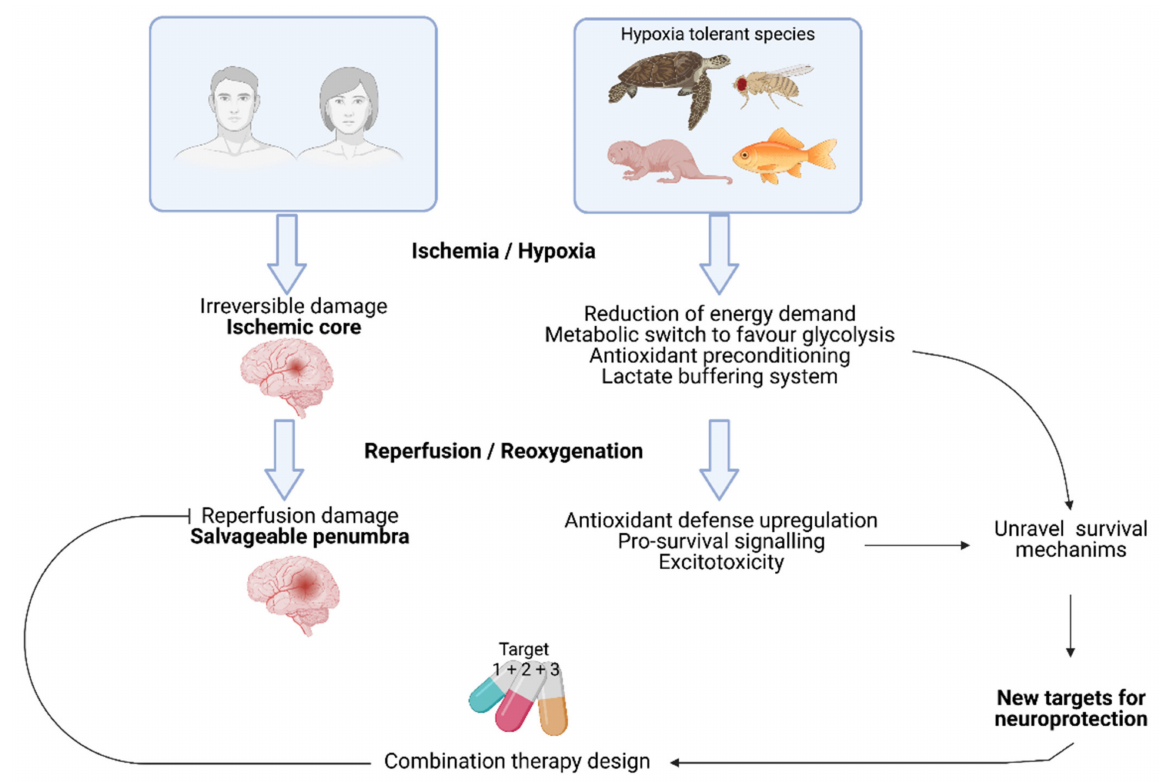
Figure 1. Human brain quickly undergoes irreversible cell death during ischemia. However, the surrounding penumbra is a salvageable tissue. Hypoxia tolerant brains have evolved different complementary mechanisms to deal with the lack of oxygen for prolonged periods of time that are not fully understood. A better knowledge of the survival mechanisms used by these animal species at the molecular level can provide new targets for neuroprotection that combined into pharmacological cocktails might help in the recovery of damaged brain